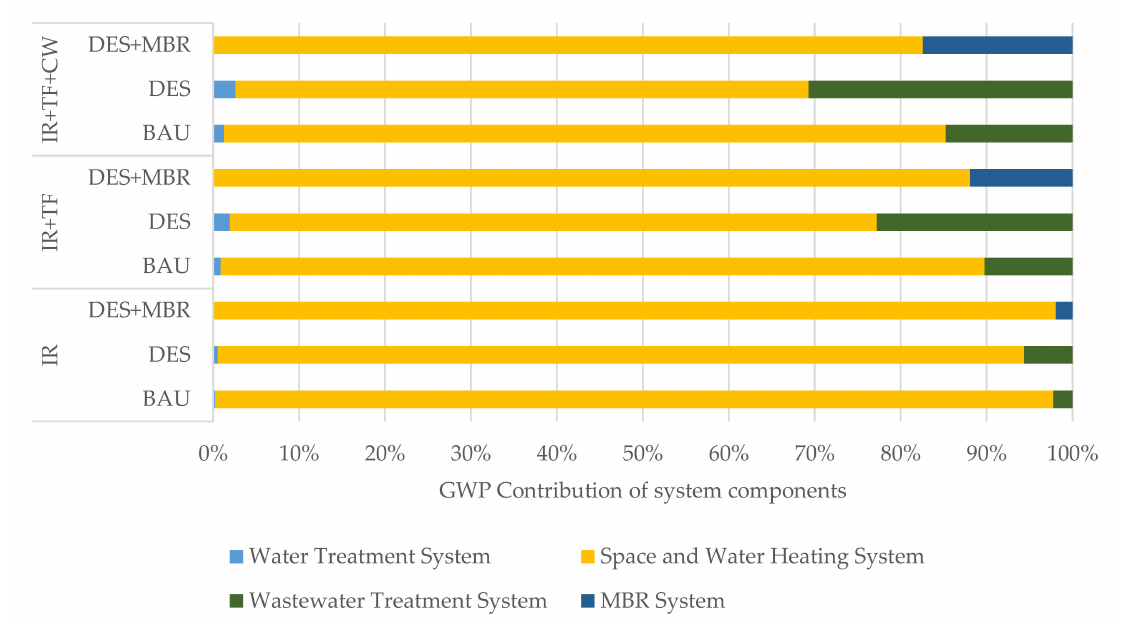
Figure 3. Global warming potential (GWP) impact contribution of system components for the three study scenarios and water reuse options: business as usual (BAU), district energy system (DES), and district energy system with membrane bioreactor (DES + MBR); irrigation (IR), toilet flushing (TF), and clothes washing